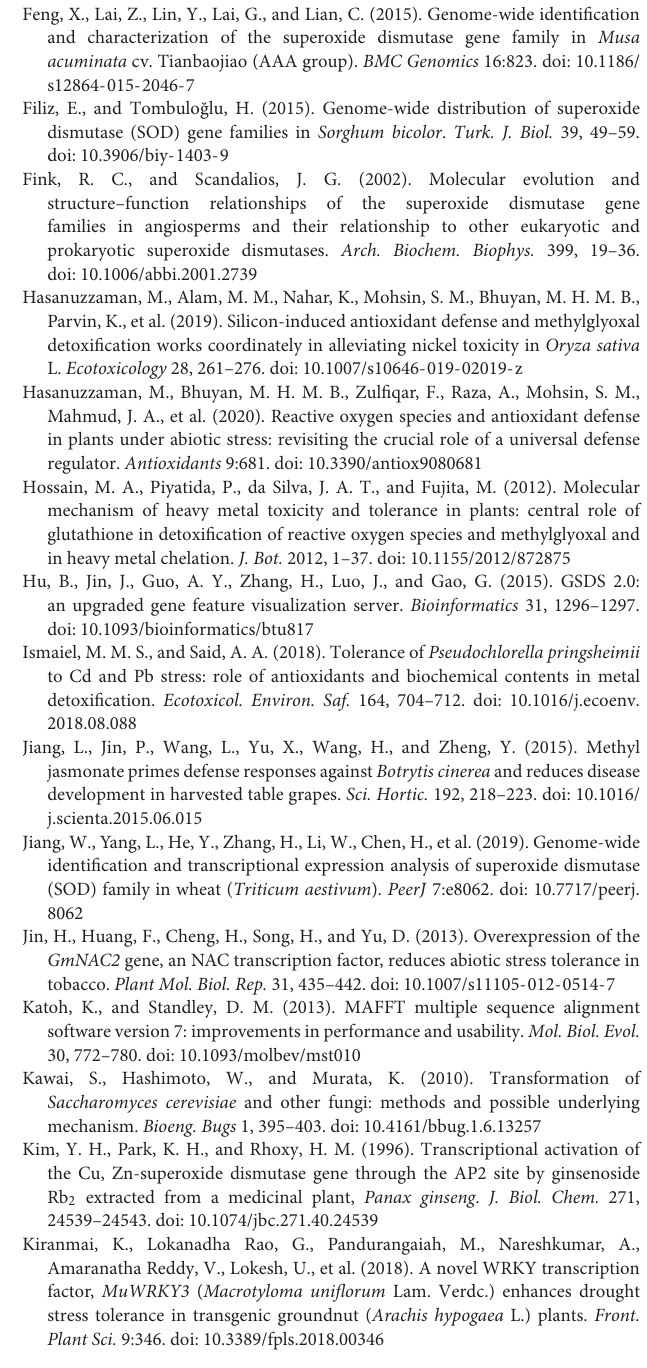
Supplementary Figure 1 | Conserved motifs of NtSODs. The number on the X-axis indicates the position of the amino acid, and the number on the Y-axis